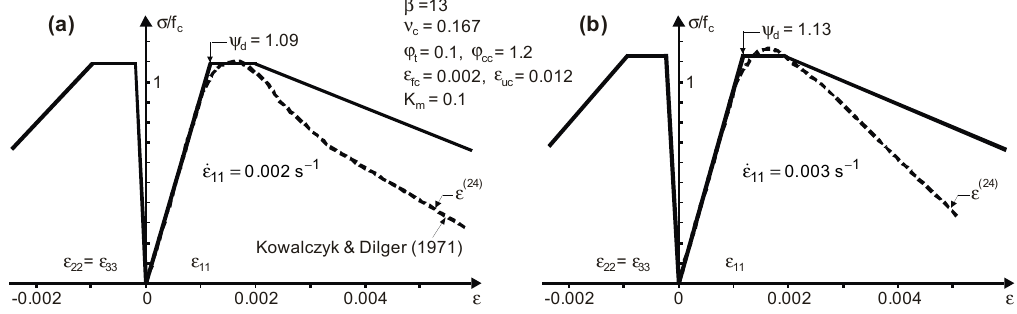
Figure 13. Comparison of the proposed model with Kowalczyk’s and Dilger’s [18] dynamic experimental results for different strain rate: ( a ) 0.002 s − 1 ; ( b ) 0.003 s − 1 .